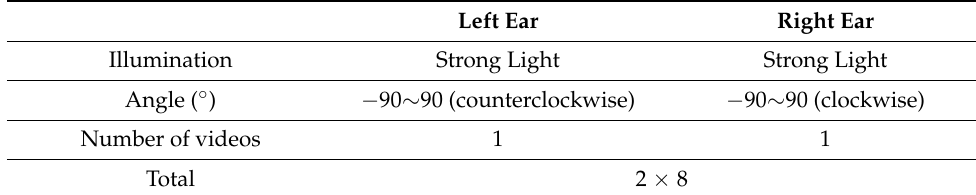
Table 7. Human ear database information of